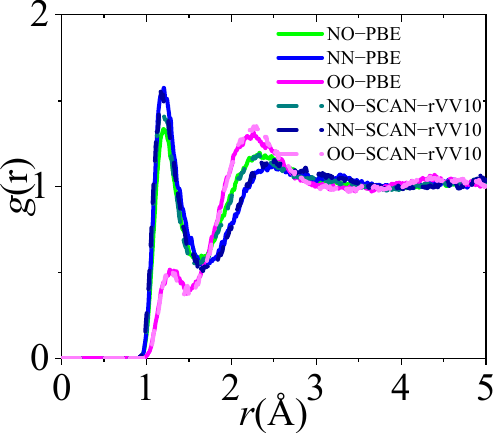
Figure 3. The present pair correlation functions at 3.20 g cm − 3 and 10,000 K calculated using PBE and SCAN − rVV10 functionals.